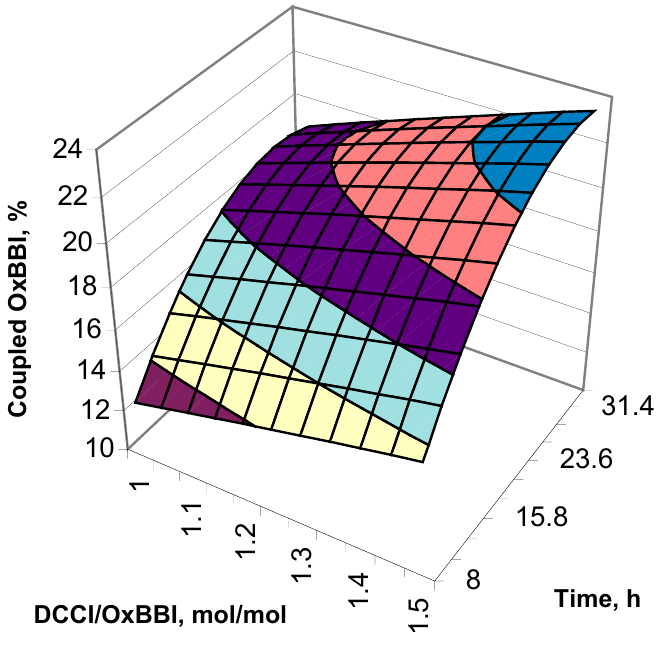
Figure 4. Influence of the DCCI/OxBBI ratio and the reaction time on the amount of OxBBI bound in the coupling product, for a gellan/OxBBI ratio=0.35.